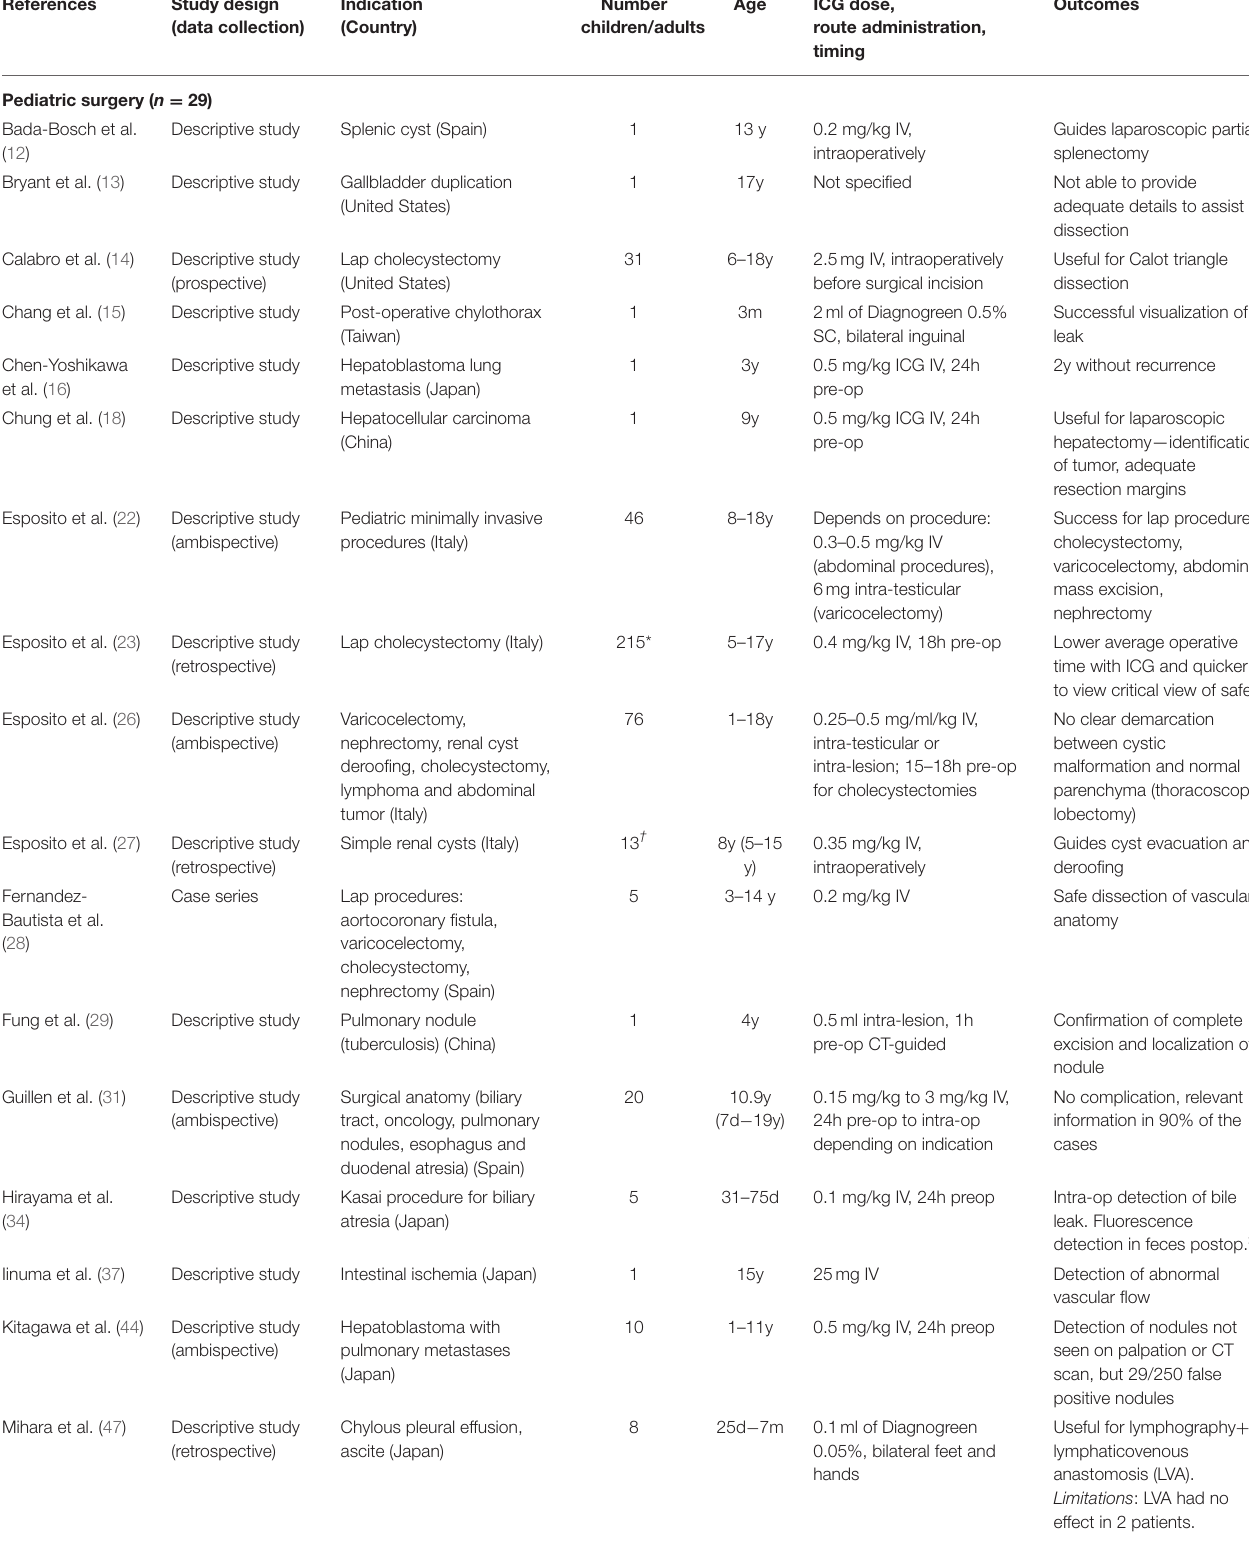
TABLE 3 | Study outcome summary separated in different surgical